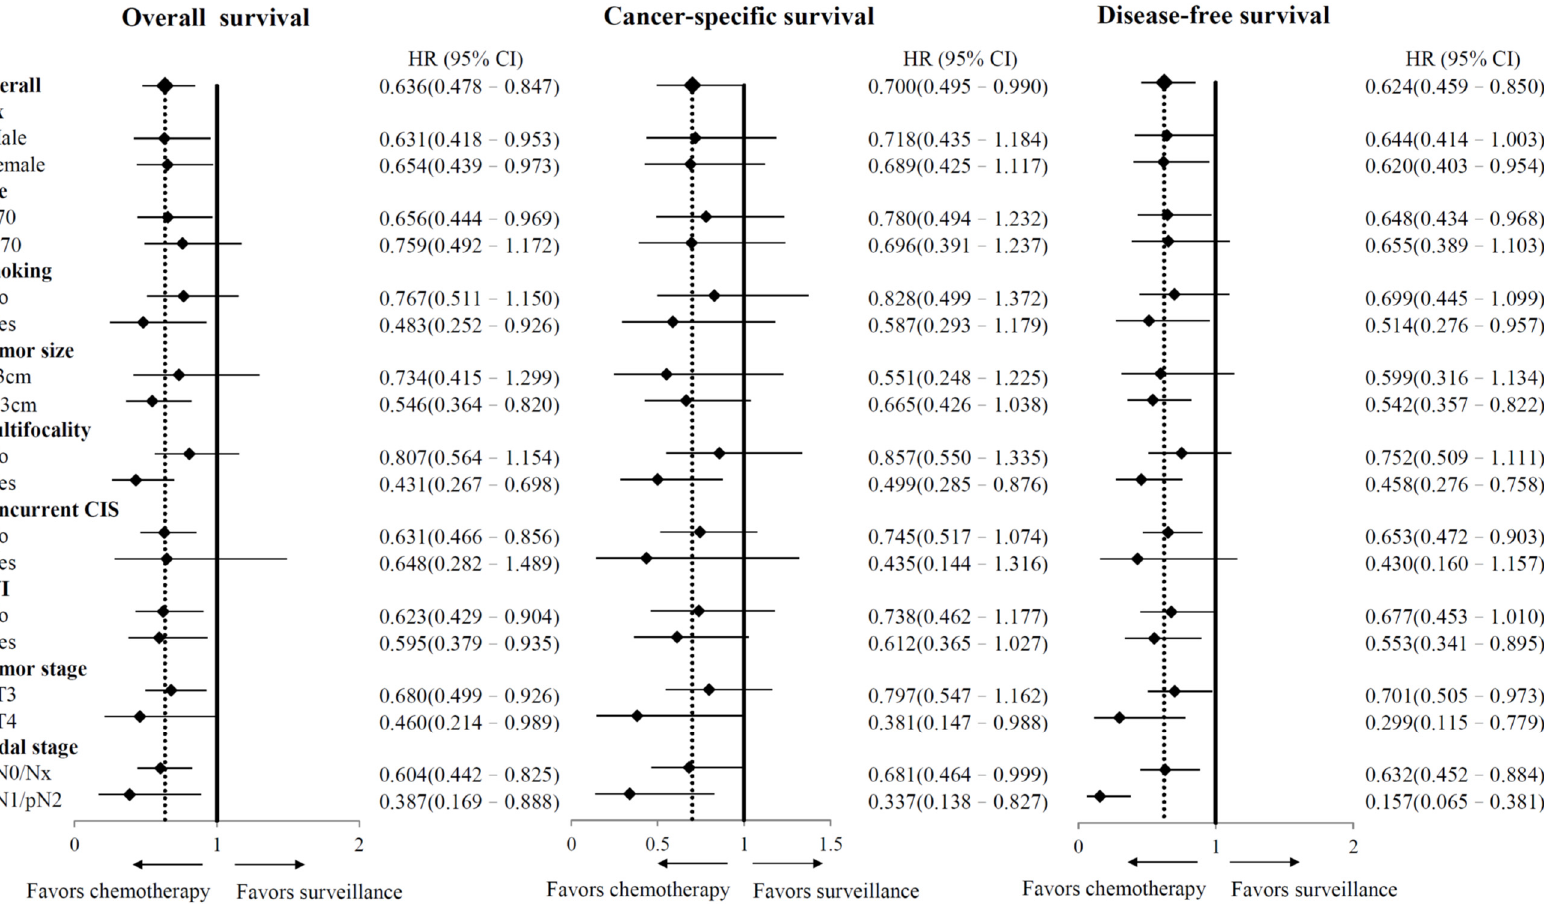
Figure 2. Subgroup analysis of overall survival, cancer-specific survival, and disease-free survival according to baseline characteristics. HR—hazard ratio; CI—confidence interval; CIS—carcinoma in situ; LVI—lymphovascular invasion.